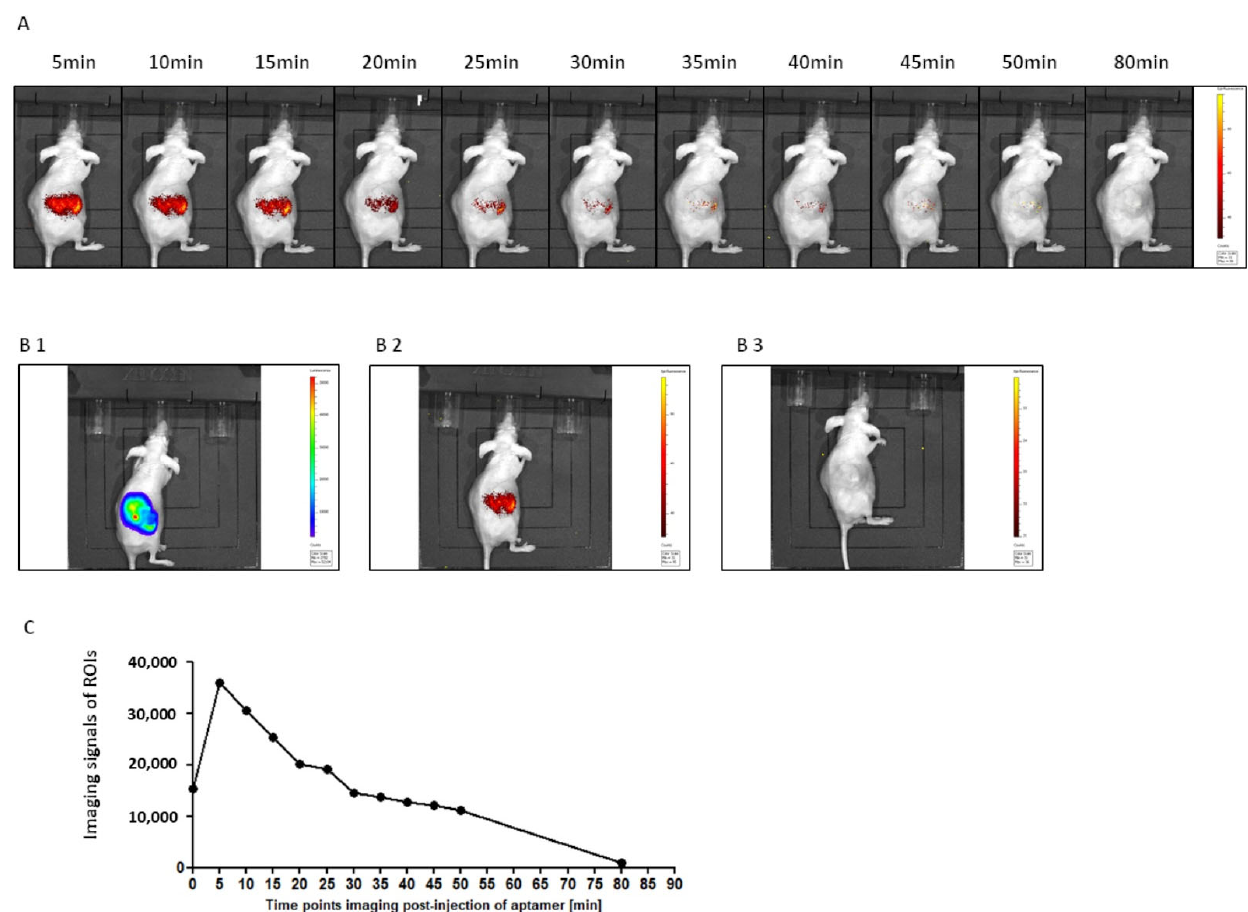
Figure 9. Tumor imaging using 2c2s probe. PD-L1-specific ssDNA aptamer probe (Cy5.5-2c2s) was administered intraperitoneally into Luc-ccRCC tumor bearing animals. ( A ) Fluorescence imaging scans were recorded at indicated time points. ( B ) Co-localization of bioluminescence ( B1 ) and fluorescence ( B2 ) 10 min after the aptamer injection. Labeled unspecific aptamer does not accumulate in the tumor ( B3 ). ( C ) Timeline of fluorescence intensity at the tumor site—numerical data derived from images in panel A.